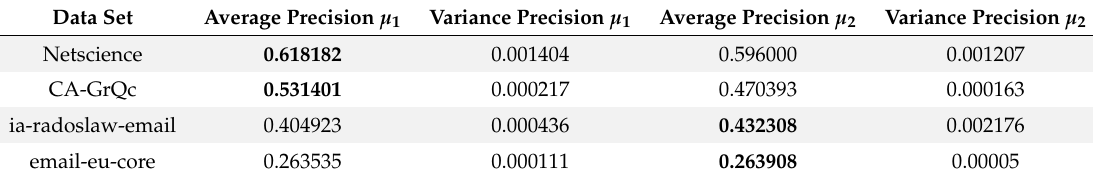
Table 5. Average precision and Variance, RAND/1/EXP strategy. Best performance in bold.